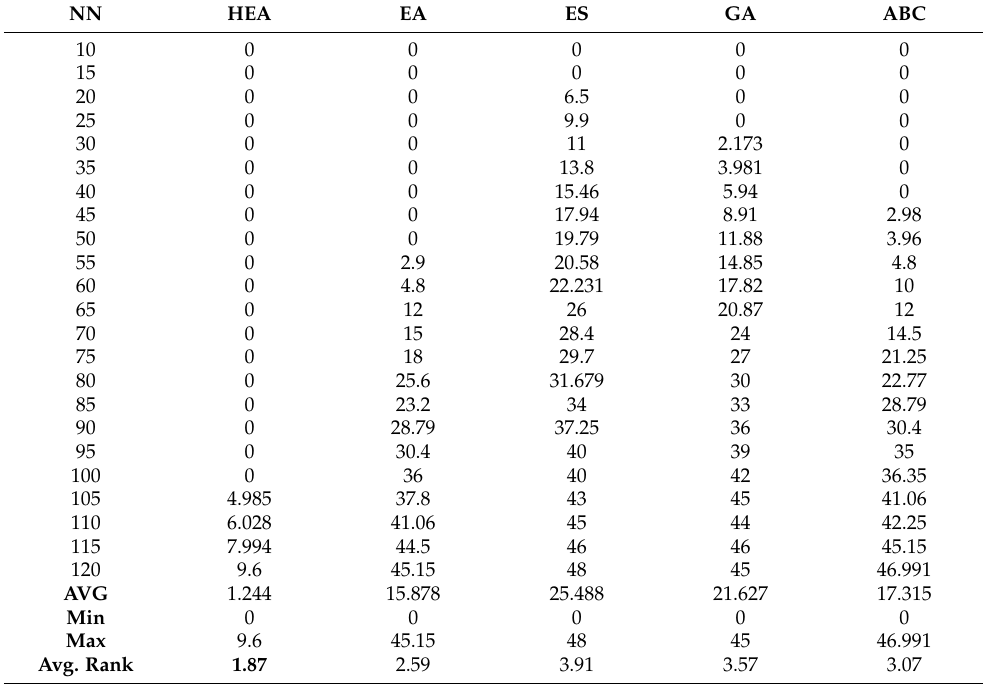
Table 5. Tabulated fitness values for different DHNN-RAN k SAT